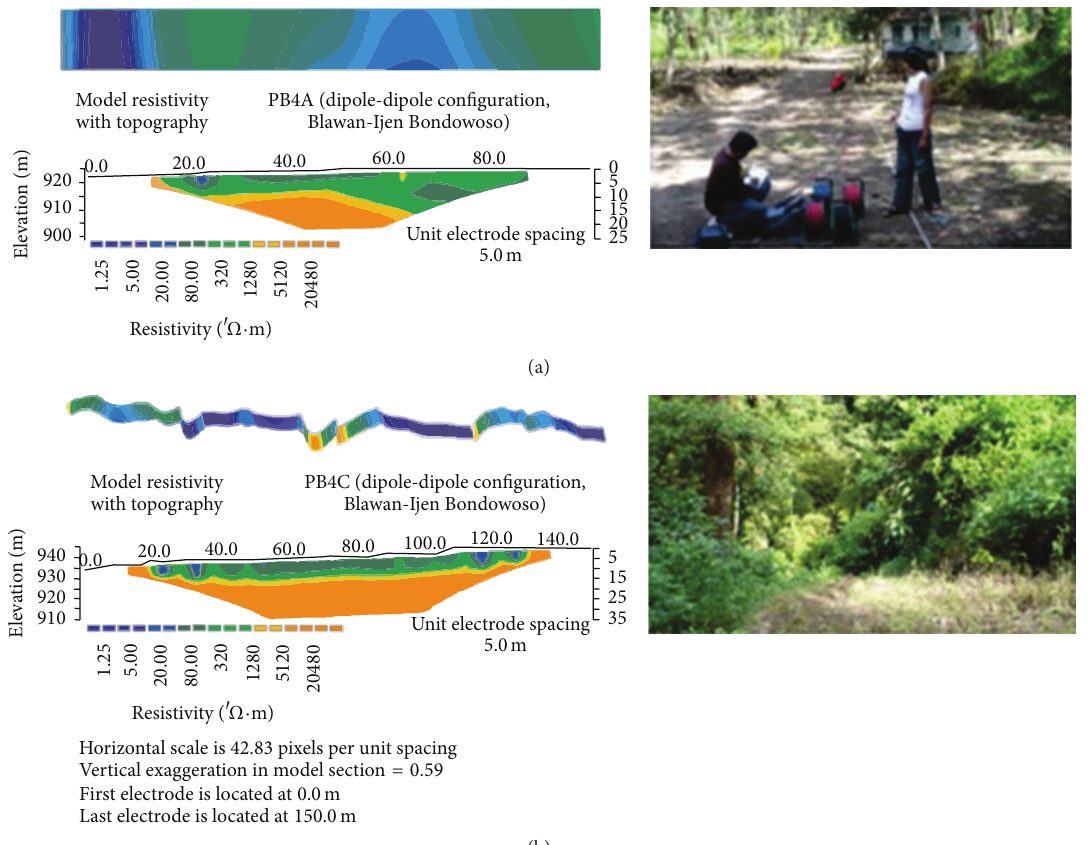
Figure 8: 2D Resistivity Mapping and GPR amplitude slice in locations (a) PB4A and (b) PB4C.